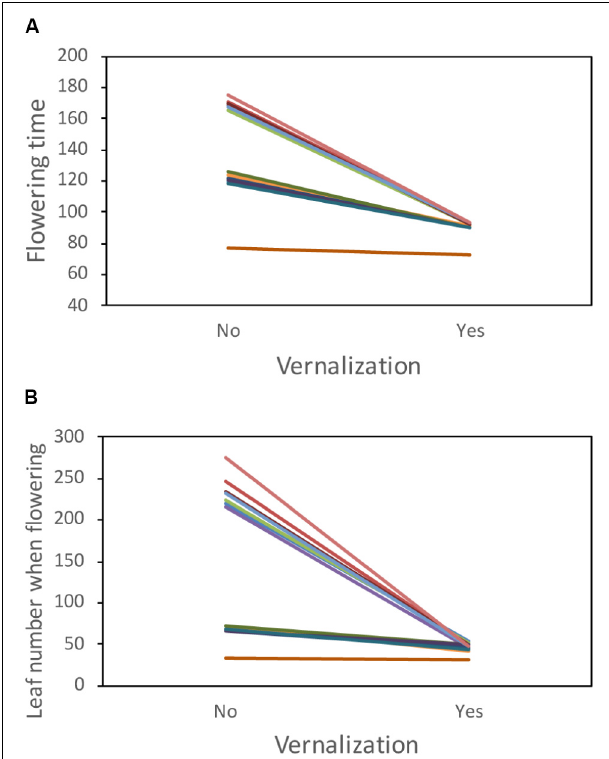
FIGURE 1 | Phenology of accessions from the Moonrise Ridge population. (A) First flowering time in days after germination and (B) leaf number when first flowering. Each colored line represents one accession. One accession, MR24, has rapid flowering regardless of vernalization treatment.